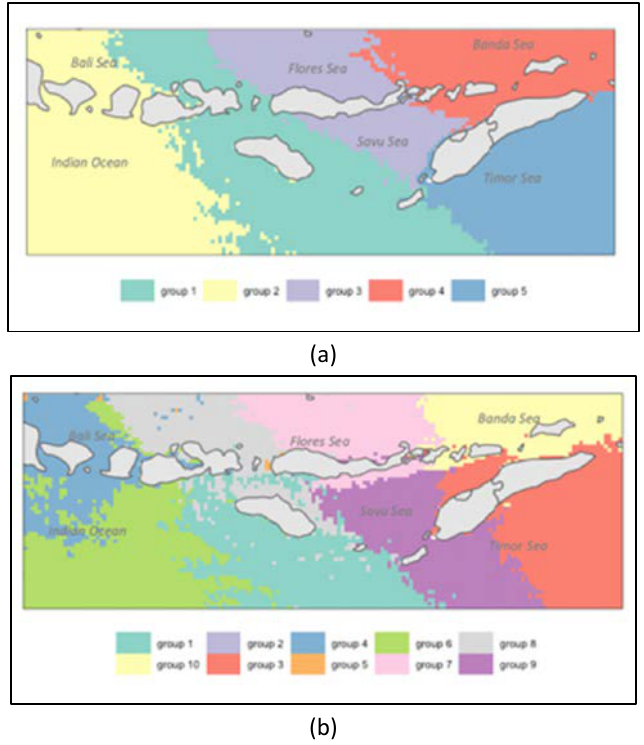
Fig. 4: Spatial delineation results of FCM clustering on the Lesser Sunda Islands (a) wet season; (b) dry season